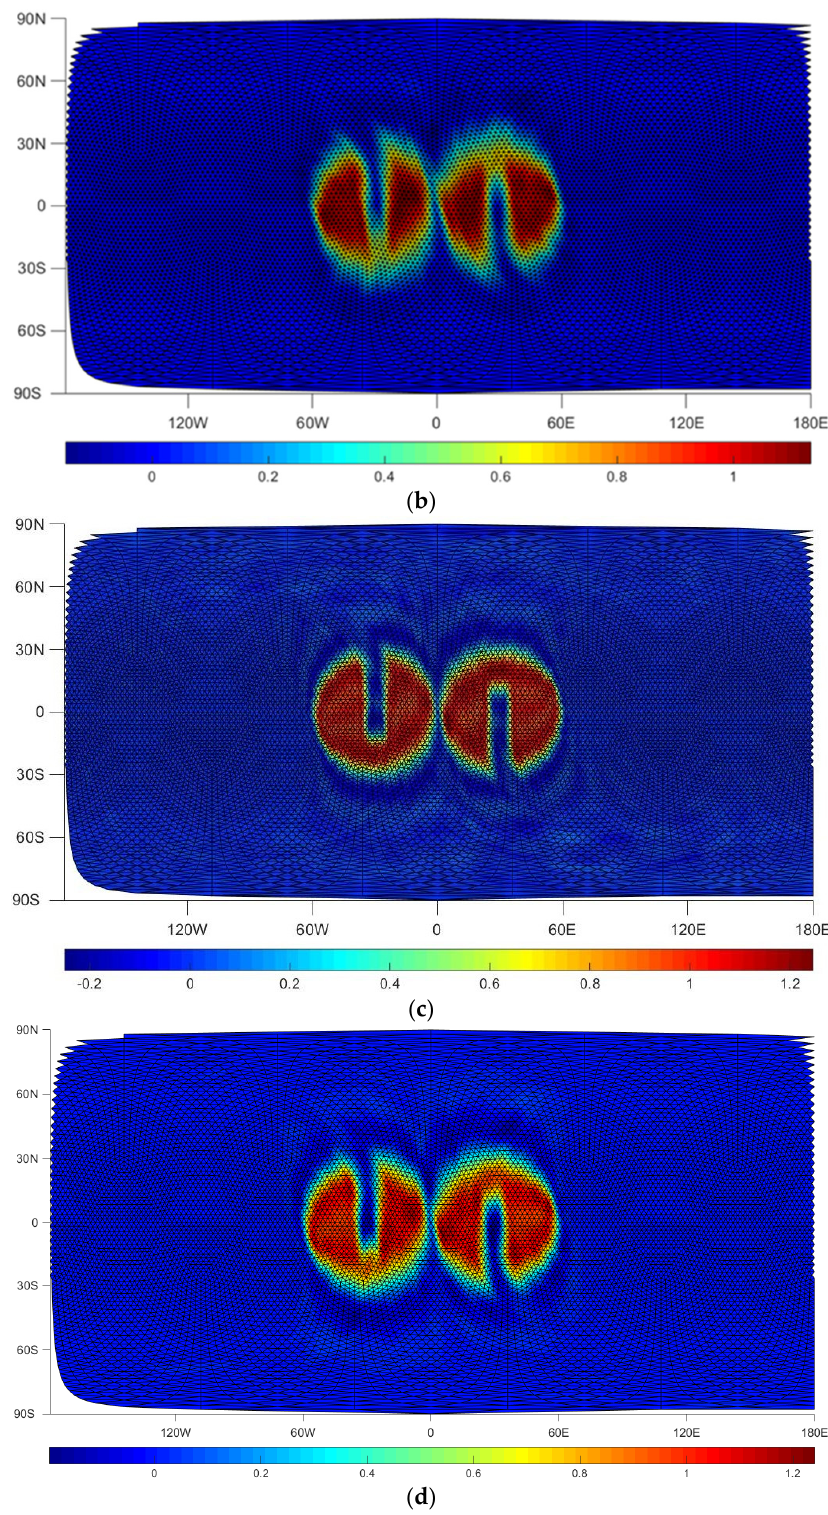
Figure 9. Shear deformation of twin slotted cylinders simulated on icosahedron sphere with refinement level 5. ( a ) Initial distributions of tracer and ( b ) The SL numerical solution of the scalar field obtained by Poly-LSQ method at final time t = T , time step ∆ t = 0.1; ( c ) The SL numerical solution of the scalar field obtained by global RBF method at final time, time step ∆ t = 0.1; ( d ) The SL numerical solution of the scalar field obtained by local RBF method at final time, time step ∆ t =